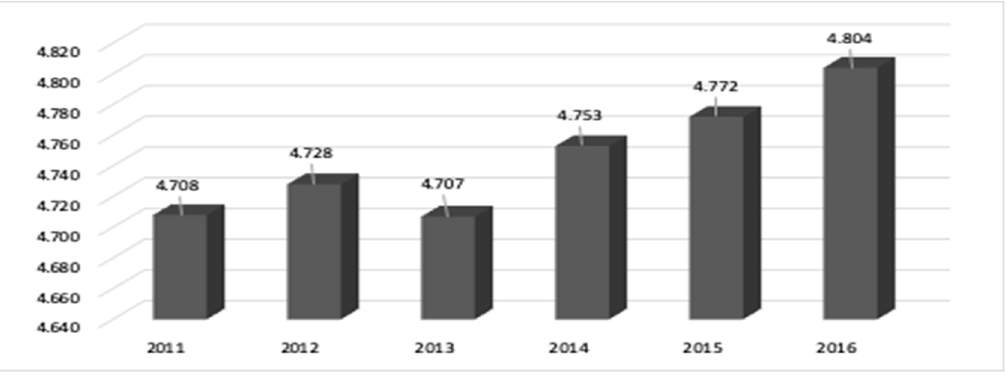
Figure 1. The dynamics of average GCI for EU-28 countries. Source: own calculation .